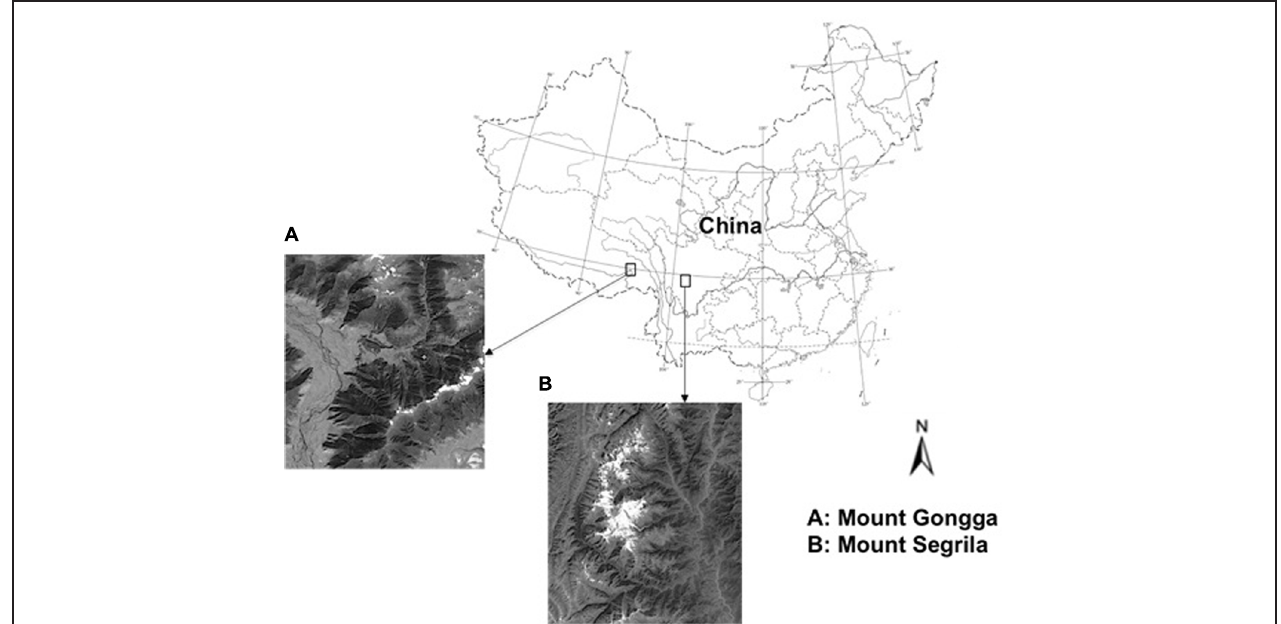
FIGURE 1 | Locations and satellite maps of the studied mountain areas in Qinghai-Tibetan Plateau, China.